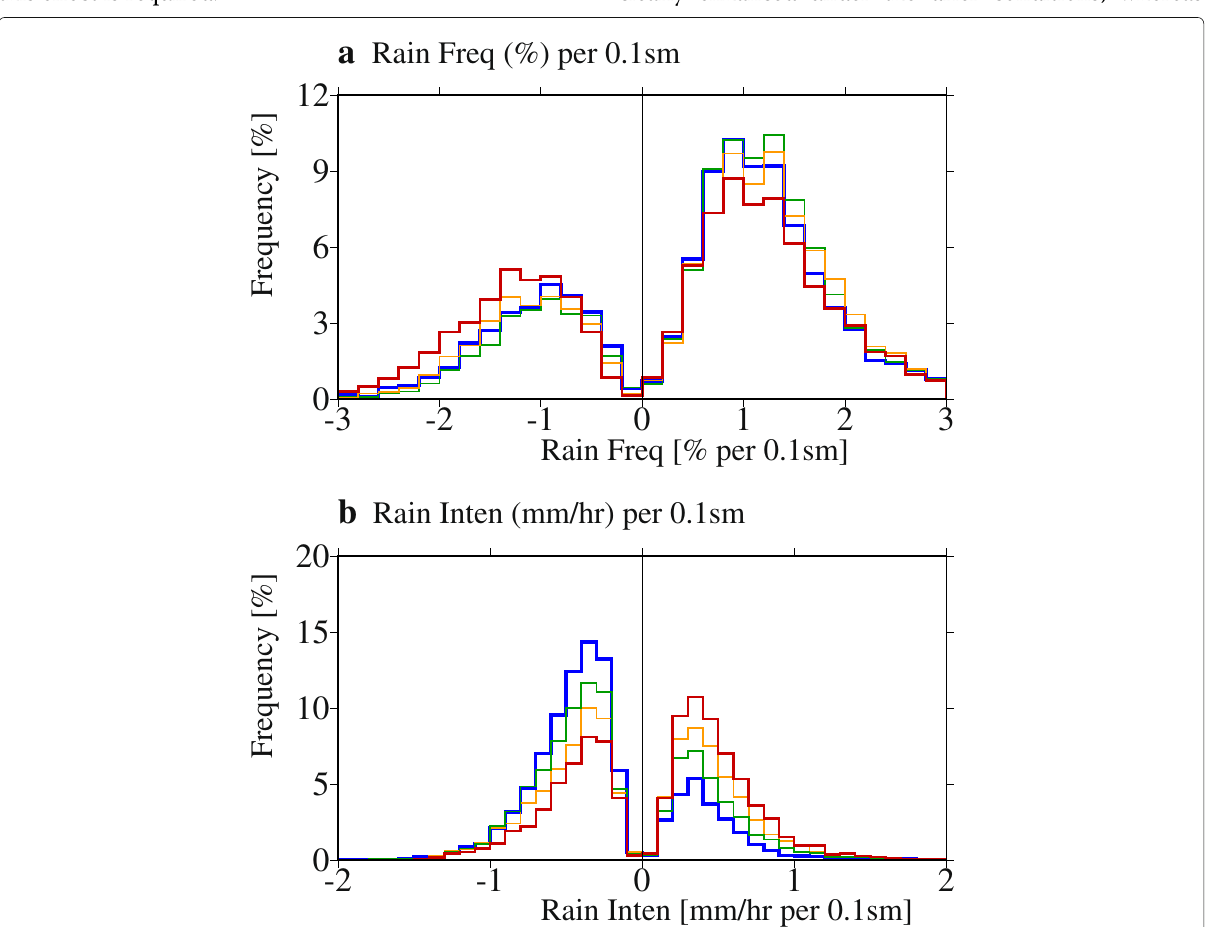
Fig. 13 Same as Fig. 5 but for PSMsens in a rainfall frequency and b rainfall intensity from different experiments over the land regions. The blue color indicates the same as in Fig. 5 (SM020 to SM045), green is SM015 to SM040, orange is SM010 to SM035, and red is SM005 to SM030. The horizontal axes in a and b are % per 0.1 increase in soil moisture and mm h − 1 per 0.1 increase in soil moisture. The vertical axes are the frequency of each bin, expressed as a